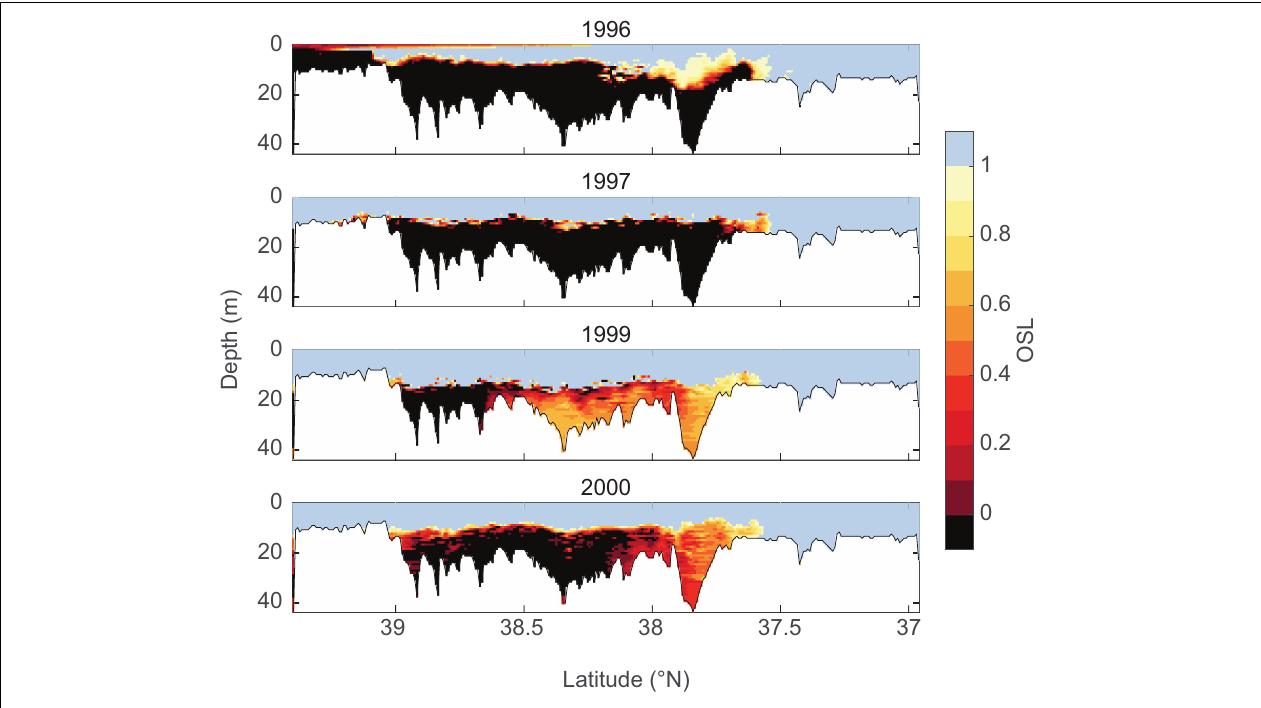
FIGURE 7 | OSL index for the copepod A. tonsa in the main channel of the Chesapeake Bay for 4 years, calculated using high resolution hydrographic data (temperature, salinity, and dissolved oxygen) collected with a Scanfish (Zhang et al., 2006). Calculations of P crit and P leth were made using equations from Elliott et al.